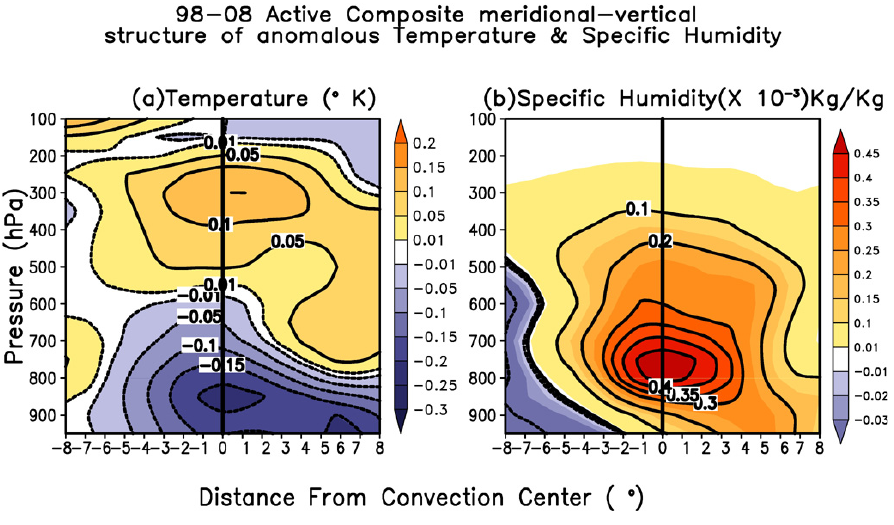
Fig. 8. Meridional-vertical structure of (a) temperature ( ◦ K) and (b) specific humidity (KgKg − 1 ) with respect to convection centre based on MERRA data.